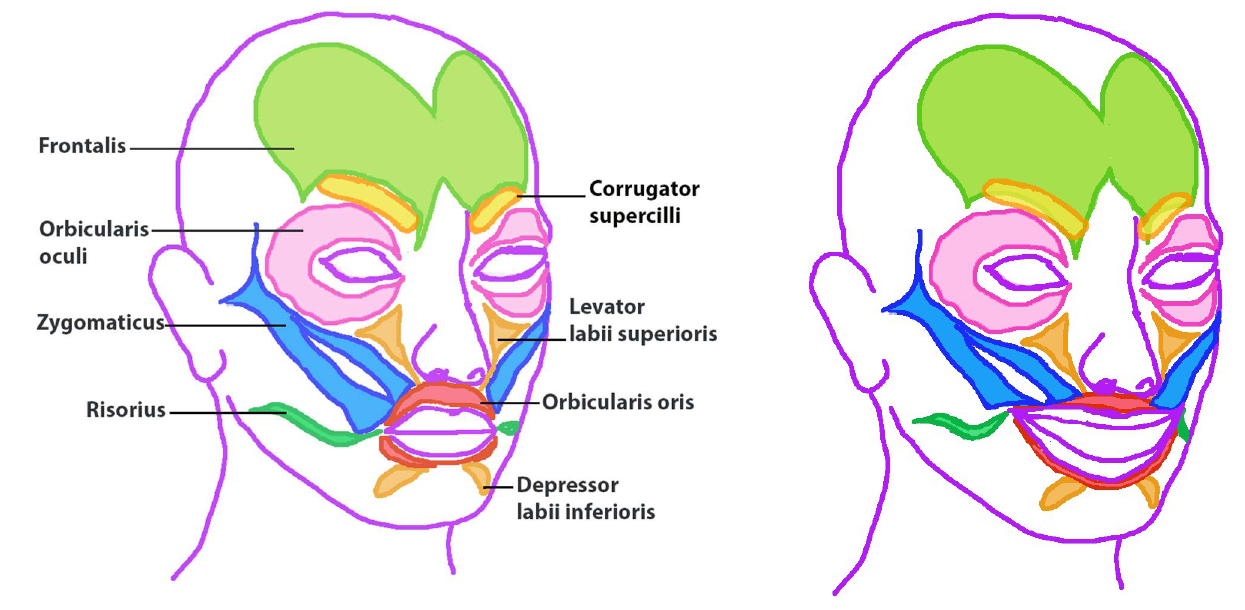
Figure 1. Diagram showing simplified facial muscle distribution, with labels on the major muscle groups associated with formation of facial expressions; notice how specific muscles contract or lengthen to change the face from a neutral (shown on the left) to a smiling expression (on the right).